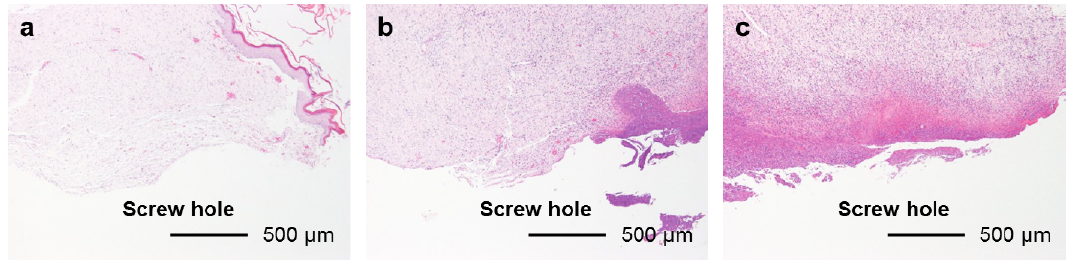
Figure 9. Percent incidence of Grades 0s, 1s, and 2s pin tract infections determined by histological observation of ( a ) the UN1, 25F0.5, 25F1.0, and 37F4.0 groups; ( b ) the UN2 and 25F2.0